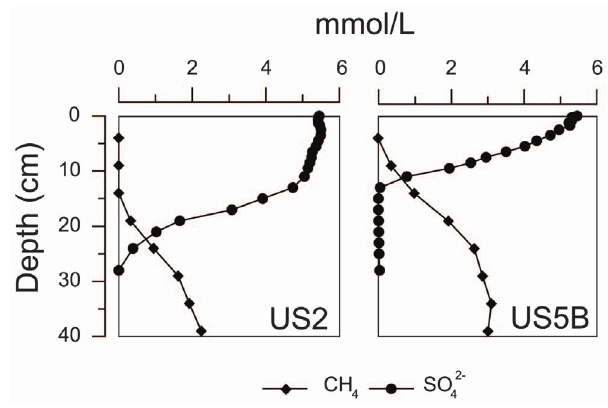
Figure 3. Porewater profiles of SO 42 2 and CH 4 for sites US2 and US5b for June 2009.